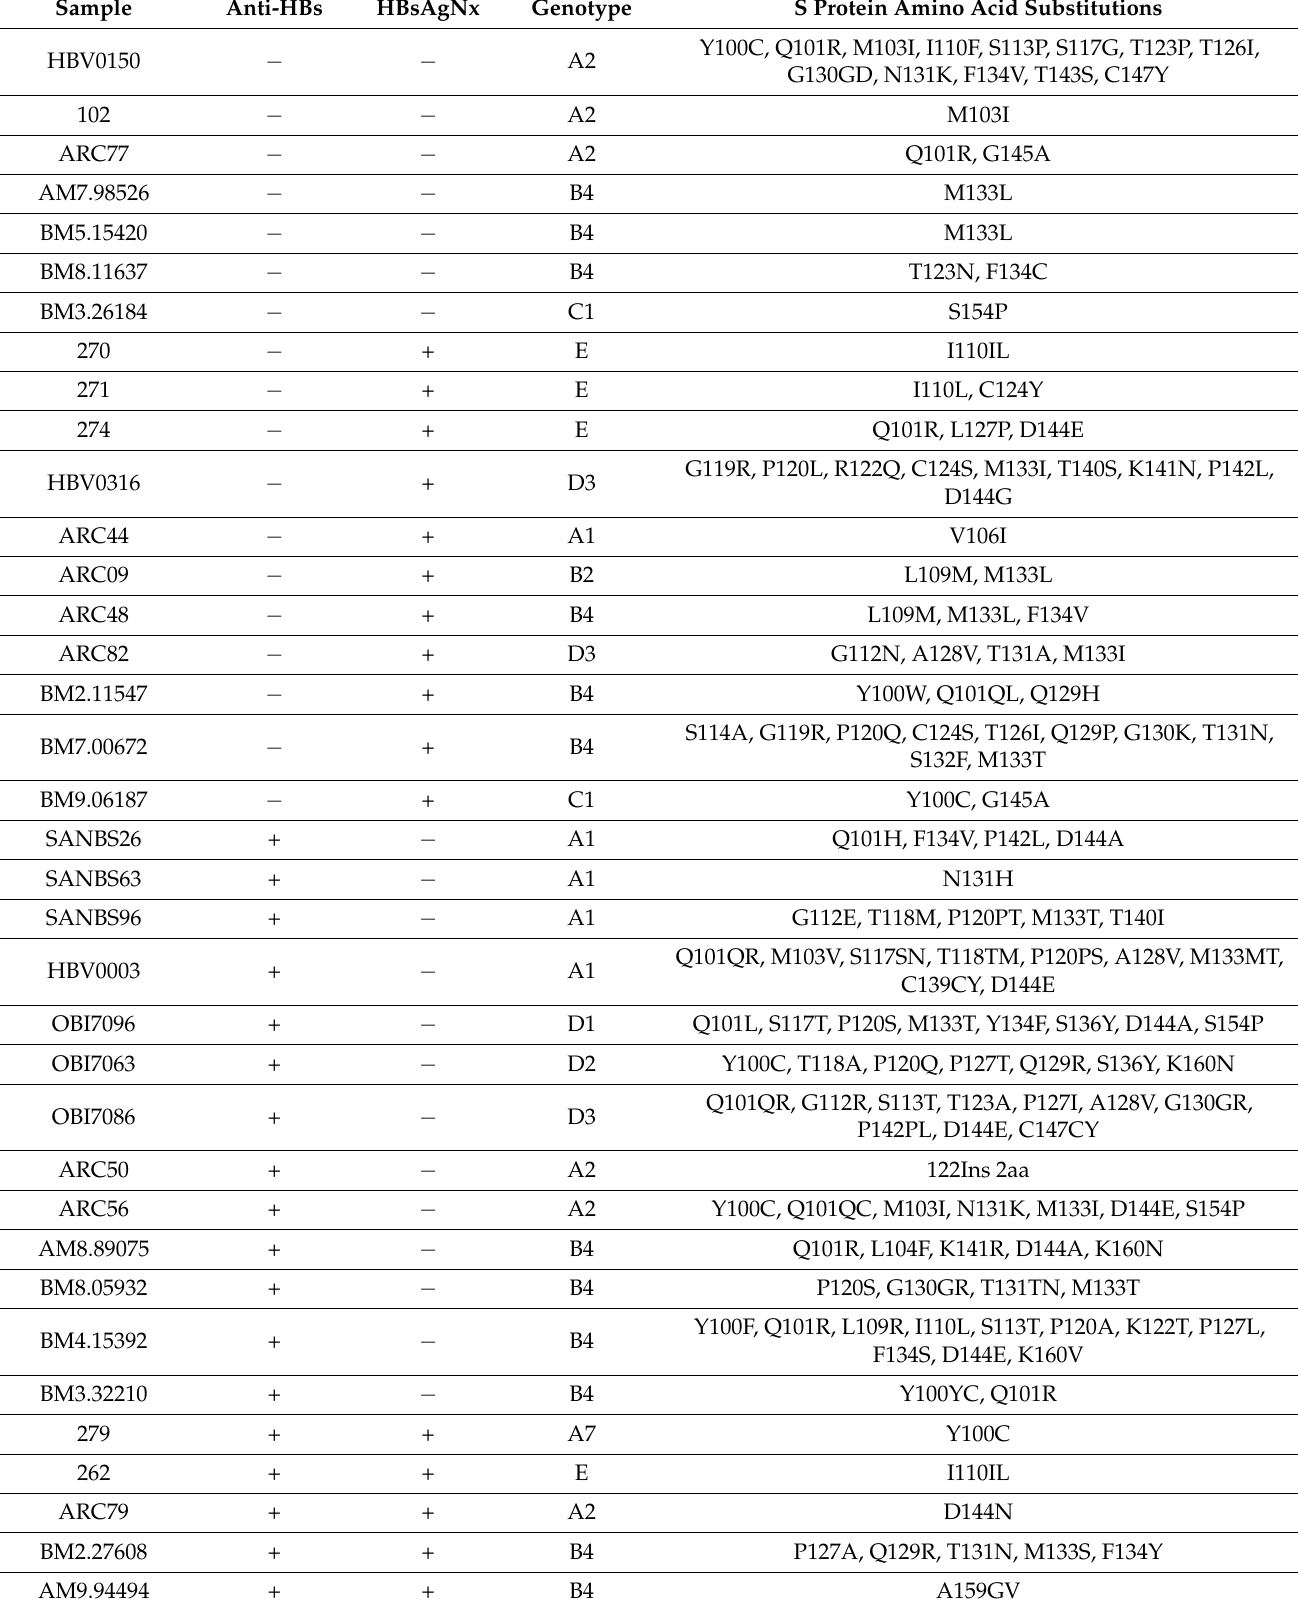
Table 3. Data for OBI samples with substitutions in amino acids 100-160 of the HBsAg S